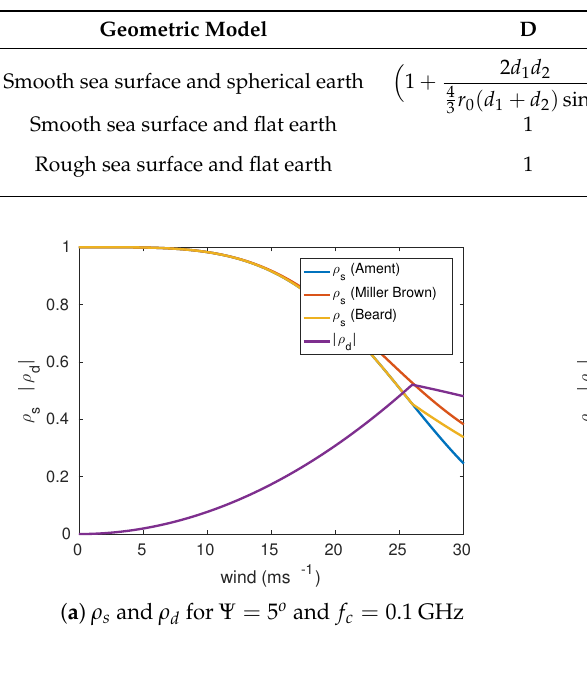
Table 2. Parameter values for the different geometric models (for spherical earth model, R 1 , R 2 and R D are detailed in Appendix A), where r 0 , the Earth radius (6371 Km) and as said in Section 2.1, ∆ p = R I − R D = R 1 + R 2 − R D . Geometric Model